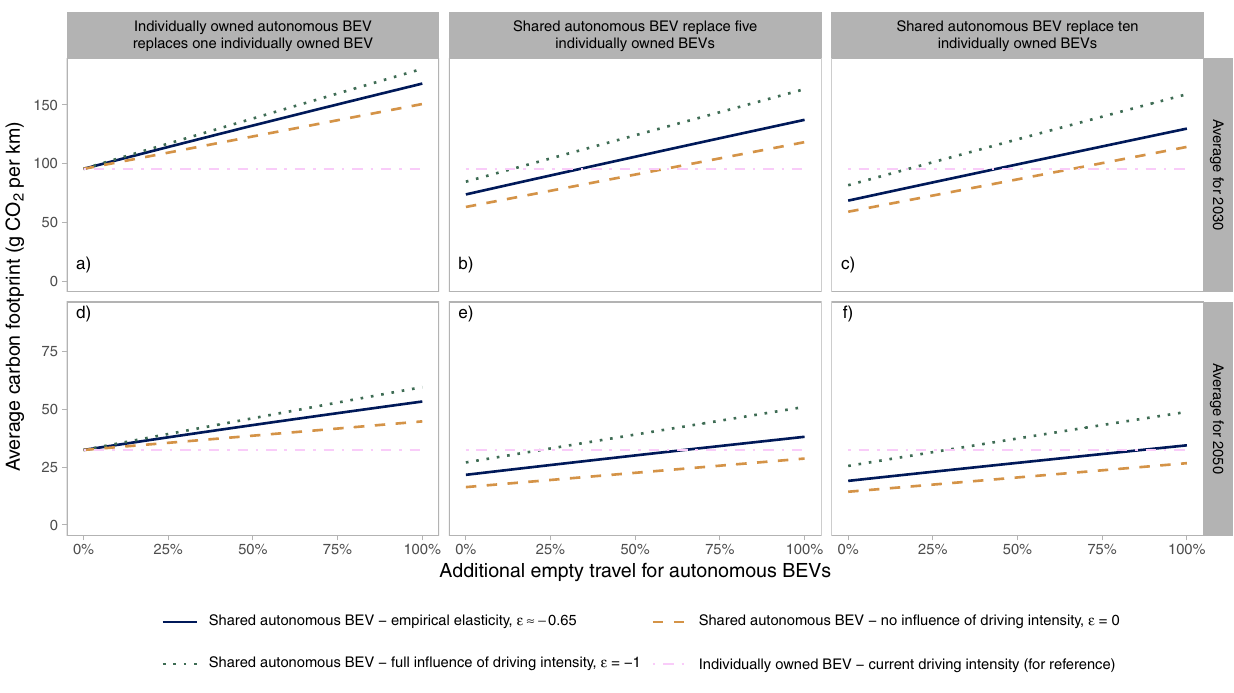
Fig. 3 | Breakeven level of empty travel. Estimated based on the average carbon footprint of individually owned autonomous BEVs that replace one individually owned BEV ( a , d ) and shared autonomous BEVs replacing fi ve ( b , e ) or ten ( c , f ) individuallyownedBEVsdependingontheelasticityofthesemi-empiricallifetime- intensity model (solid: shared autonomous BEV – empirical elasticity, ε ≈ − 0.65,